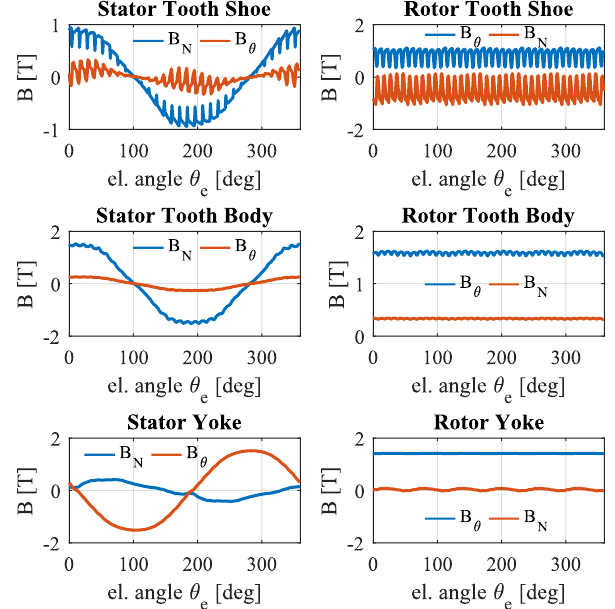
Figure 12. Normal and tangential flux-density variation in several parts of the machine: the high frequency variation of the induction is very clear.